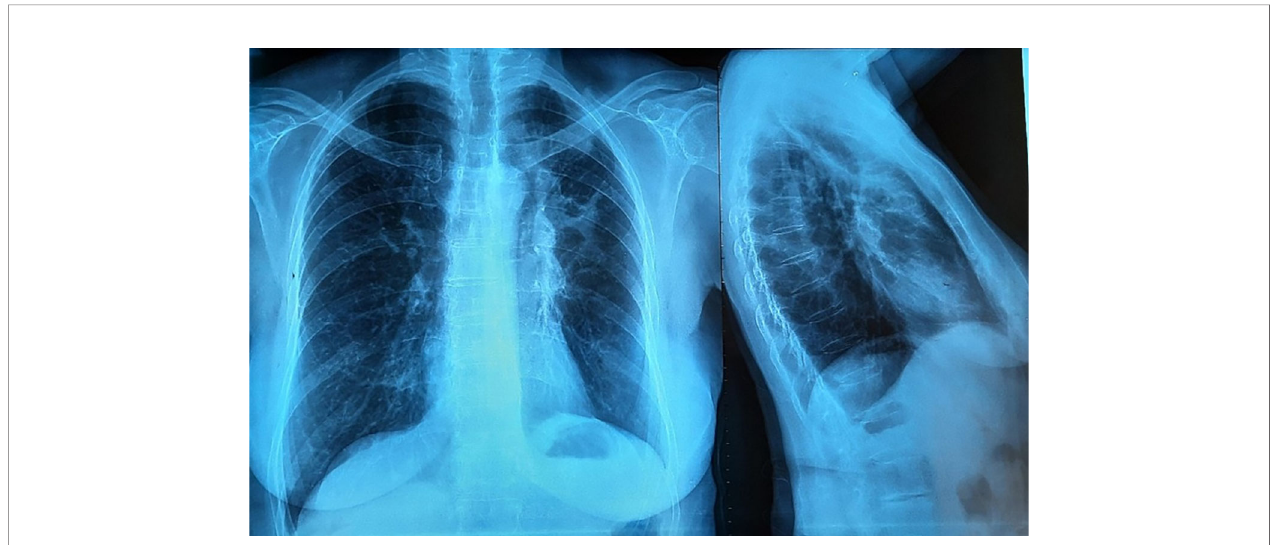
FIGURE 1 | Left hilo-axillary linear opacity associated with retraction signs evoking atelectasis on chest-ray face and pro fi